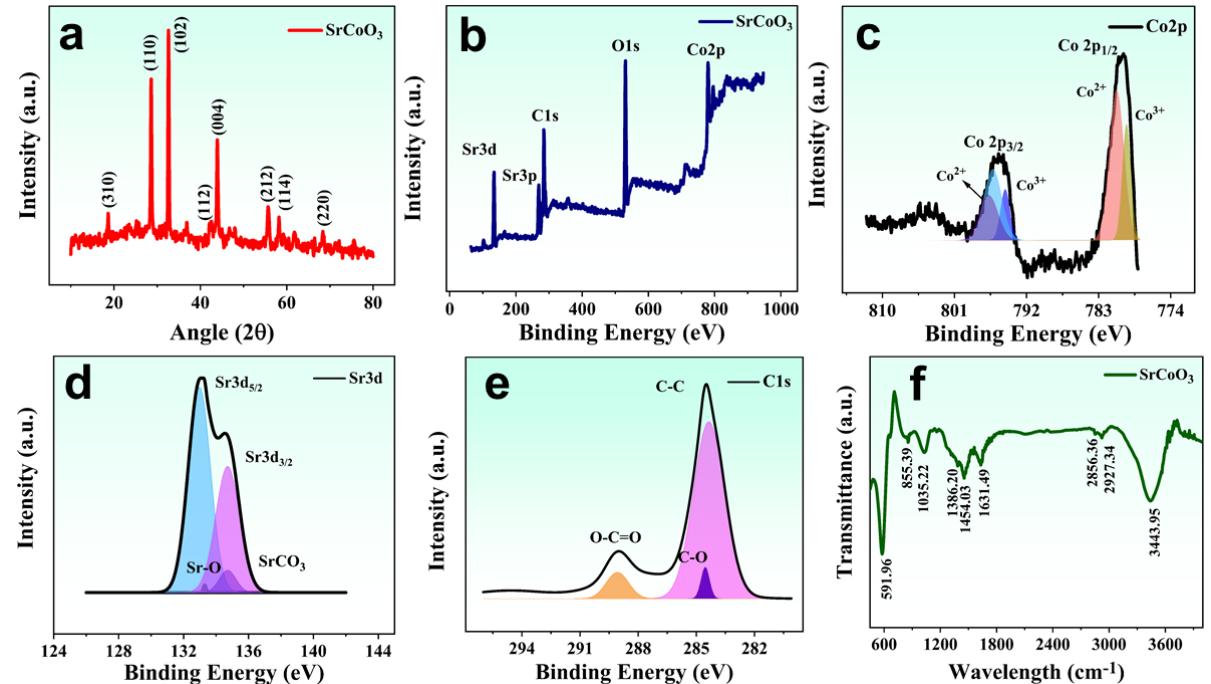
Figure 2. ( a ) XRD spectra of SrCoO 3 . ( b ) XPS survey of SrCoO 3 . High-resolution XPS spectra of ( c ) Co2p, ( d ) Sr3d, and ( e ) C1s. ( f ) FTIR spectrum of perovskite SrCoO 3 .